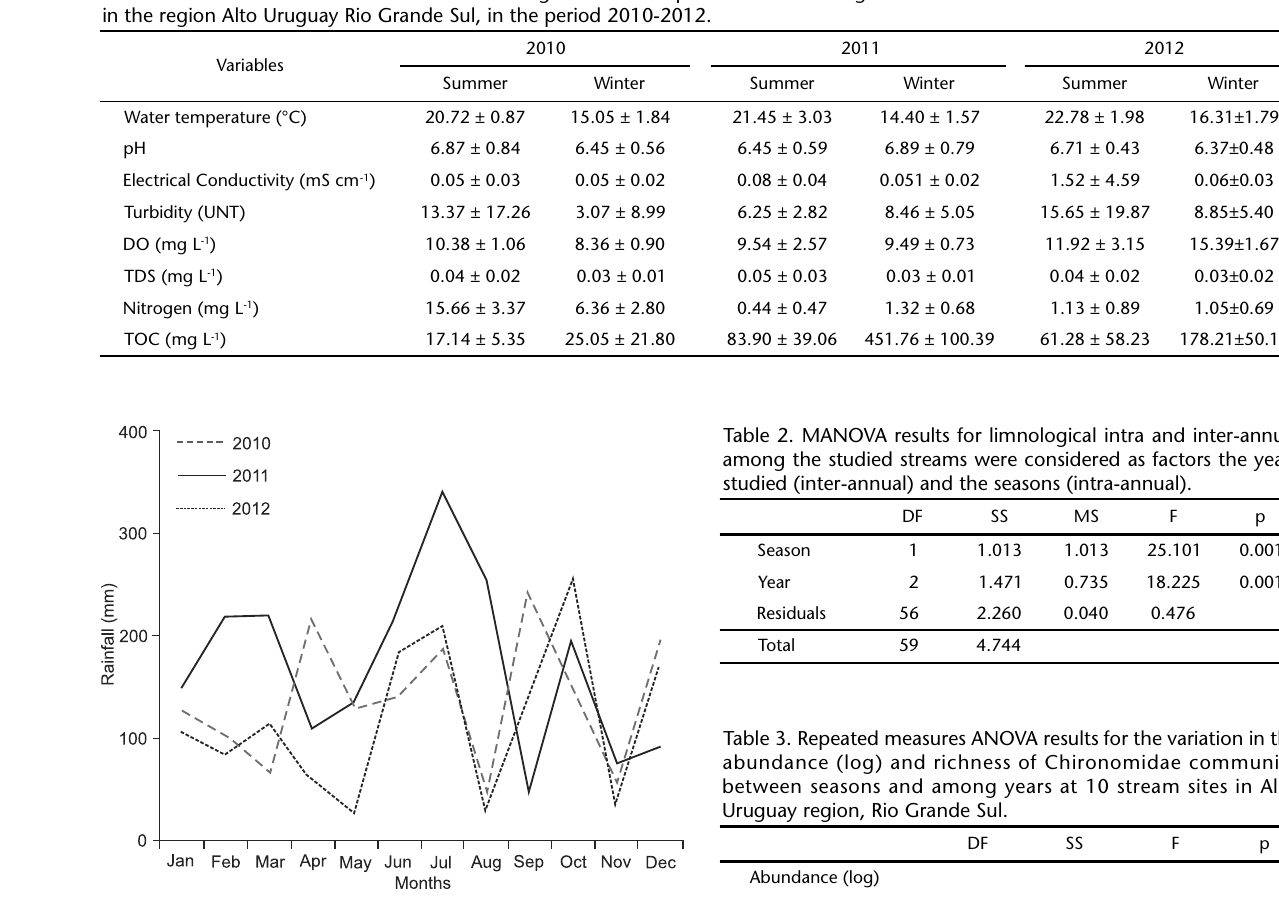
Figure 2. Monthly rainfall in the years 2010, 2011 and 2012 at Alto Uruguay region, RS. The horizontal lines indicate the annual aver- age for the respective years